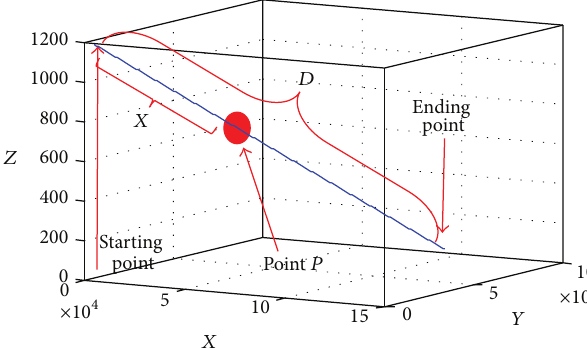
The variation of parameter 𝑡 from all equations with the iteration number can be seen in Figure 3. The parameter 𝑡 calculated for each antenna is mostly small (but positive) except at the last tens of iterations. On the other hand, the 𝑡 value from (19) calculated at the end of each loop linearly increases from 0 to 1.